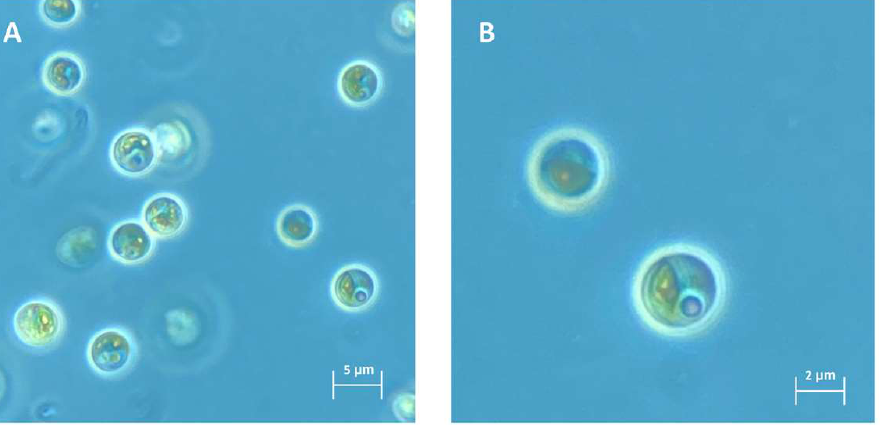
Figure 1. Morphological characteristics of strain NFX-FRZ cultivated in algae culture broth.